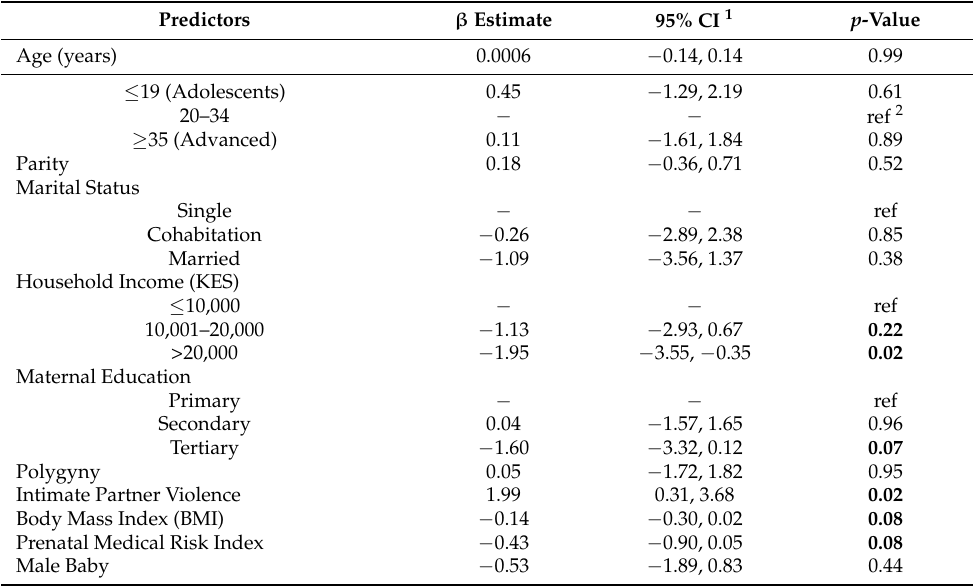
Table A1. Results of bivariate analysis between socio-demographic predictors and Perceived Stress Scale (PSS) scores.